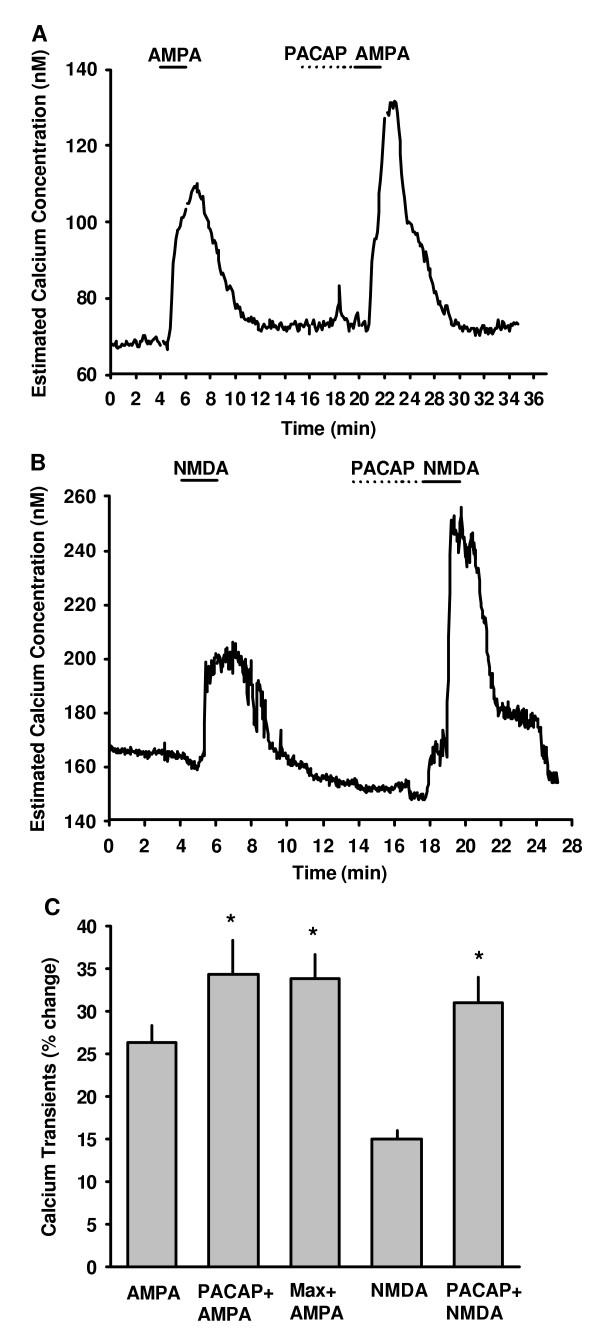
PACAP enhanced AMPA- and NMDA-evoked Ca2+ responses in a subset of mouse SCN neurons. Optical imaging techniques were used to estimate Ca2+ responses to AMPA and NMDA in ventral SCN neurons during the night (ZT 15–17). (A) AMPA (25 μM)-induced Ca2+ transients were also enhanced by the pre-treatment with PACAP (10 nM, 240 sec). (B) NMDA (25 μM)-induced Ca2+ transients were also enhanced by the pre-treatment with PACAP (10 nM, 240 sec). (C) Histograms summarizing PACAP modulation of AMPA and NMDA-evoked Ca2+ transients in the SCN. The enhancement of AMPA-evoked Ca2+ transients was mimicked by the PAC1 receptor agonist maxadilan (Max, 100 nM, 240 sec). This data was collected in the presence of TTX. Asterisks indicate values that are significantly greater than those of the AMPA- or NMDA-treated groups (P < 0.05)